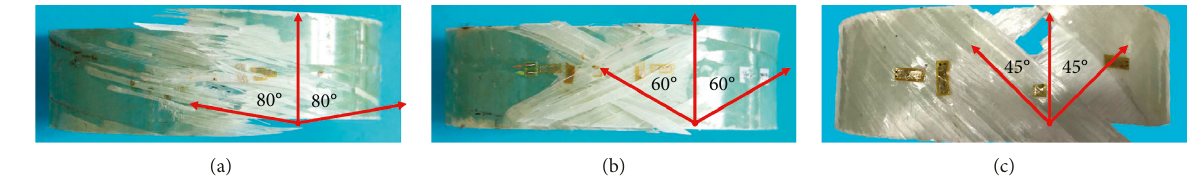
Figure 4: Typical FRP rings after the split-disk test. (a) θ � ± 80 ° ; 60 mm in width. (b) θ � ± 60 ° ; 60mm in width. (c) θ � ± 45 ° ; 60mm in width.